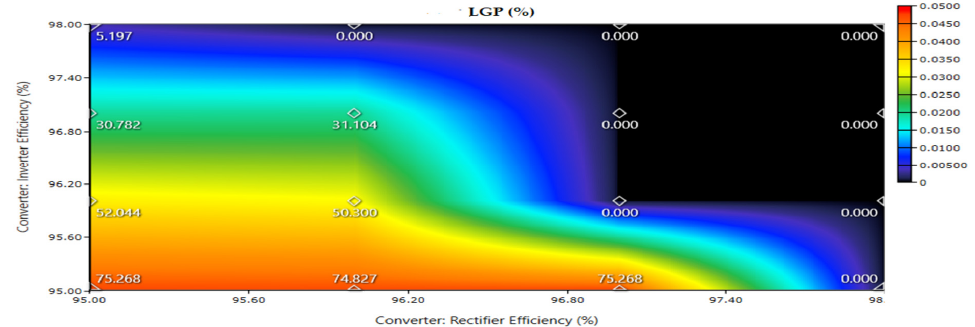
Figure 23. Variation of LGP considering fluctuation of inverter and rectifier efficiency (superimposed: ENS).